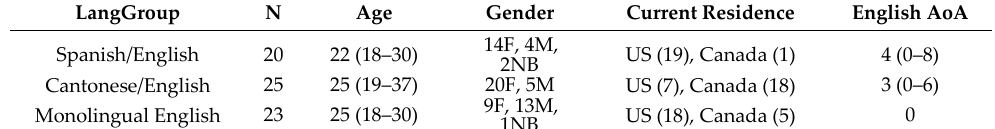
Table 2. Summary of demographic information. Age and English Age of Acquisition (AoA) give means and ranges in parentheses. For English AoA, 0 refers to “from birth.” Gender was self‑ reported with terms chosen by the participant; in the table below, F encompasses {female/woman